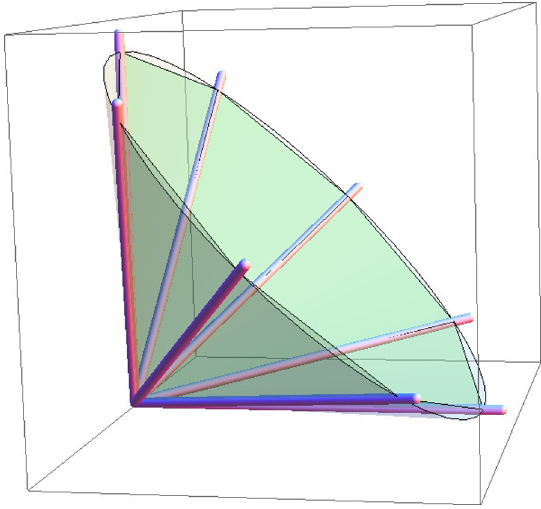
√ 2 r, r 2 ) , and its inscribed octagonal cone, by taking N = 4 in